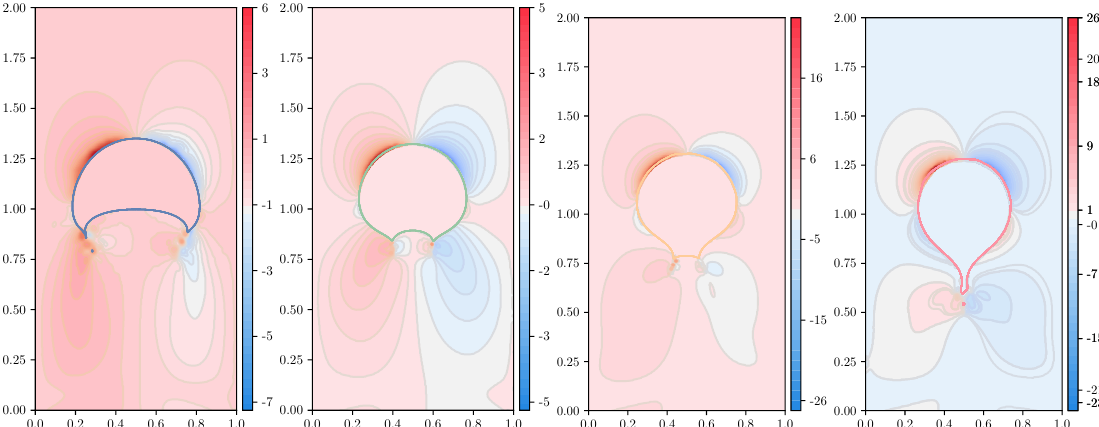
Figure 14. Drop shape and shear component of the polymer stress tensor τ p ,12 for the FENE model ( b = 50) with ρ 2 / ρ 1 = 10 − 3 , µ 2 / µ 1 = 10 − 2 , at t = 3. From left to right, c = 1, De = 1; c = 3, De = 1; c = 5, De = 3; and c = 9, De =